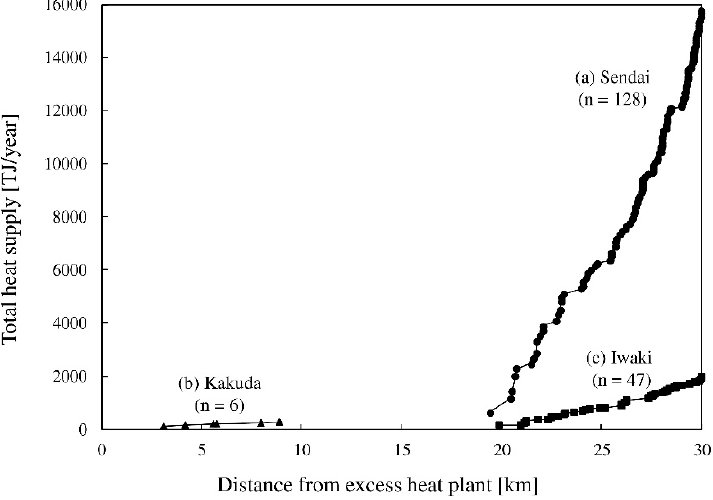
Figure 9. The relationship between the distance from the excess heat plant and total heat supply of a DHS.